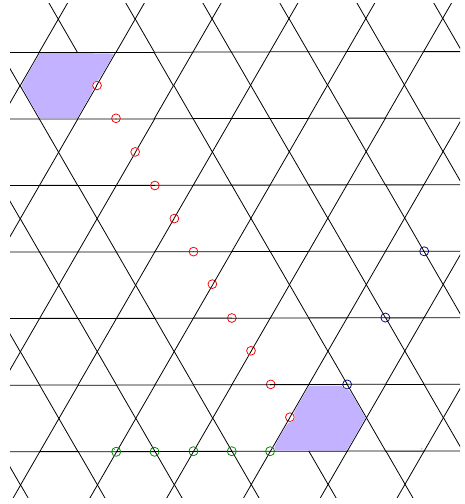
14. Red circles denote defects as in Eq. (13), with a pair of parafermions (purple) emerging at the ends of the defect line. X † Blue circles correspond to terms of the form X , while green j þ j Z † . These grow the e circles correspond to terms of the form Z j þ j and m parts of the defect line, respectively. Once both the blue and green defect lines have been added, the red defect line can be removed. The ψ particle initially stored in the red defect line has g then been split into its e and m g g